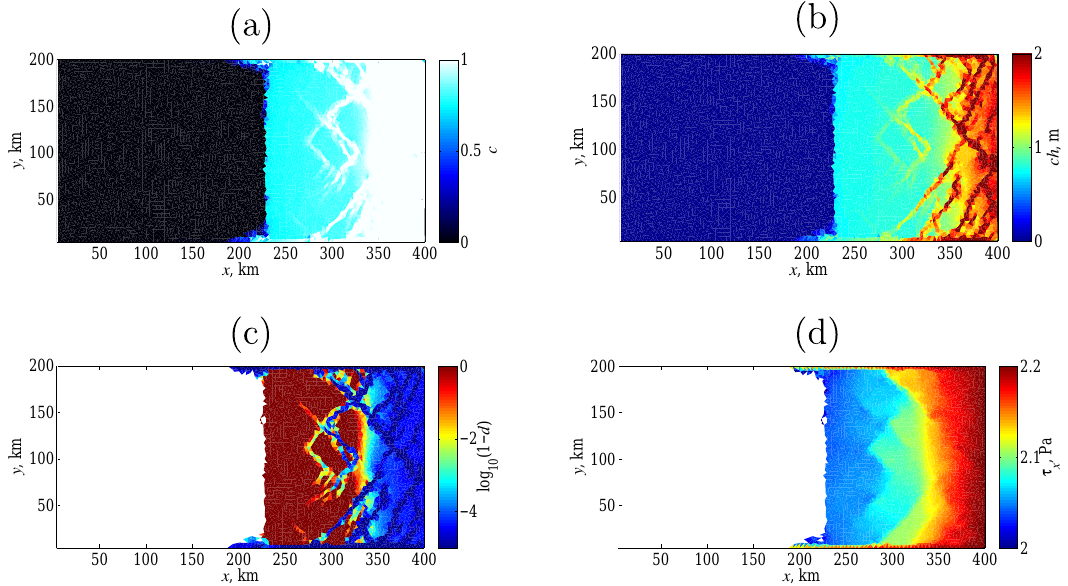
Figure 1. Results after forcing from uniform, steady wind (with speed 14.9ms − 1 , from the left) have been applied for 48h. Initially, constant ice conditions were applied ( c = 0 . 7, h = 1m, d = 0) to the right of the ice edge, which corresponded to approximately x = 124km. The upper, lower and right-hand boundaries are closed. Fields plotted are (a) concentration, (b) effective thickness, (c) the damage (with blue being more damaged and red less) and (d) the x component of the wind stress τ a . There are no wave interactions considered, C = 40 and = τ L 0